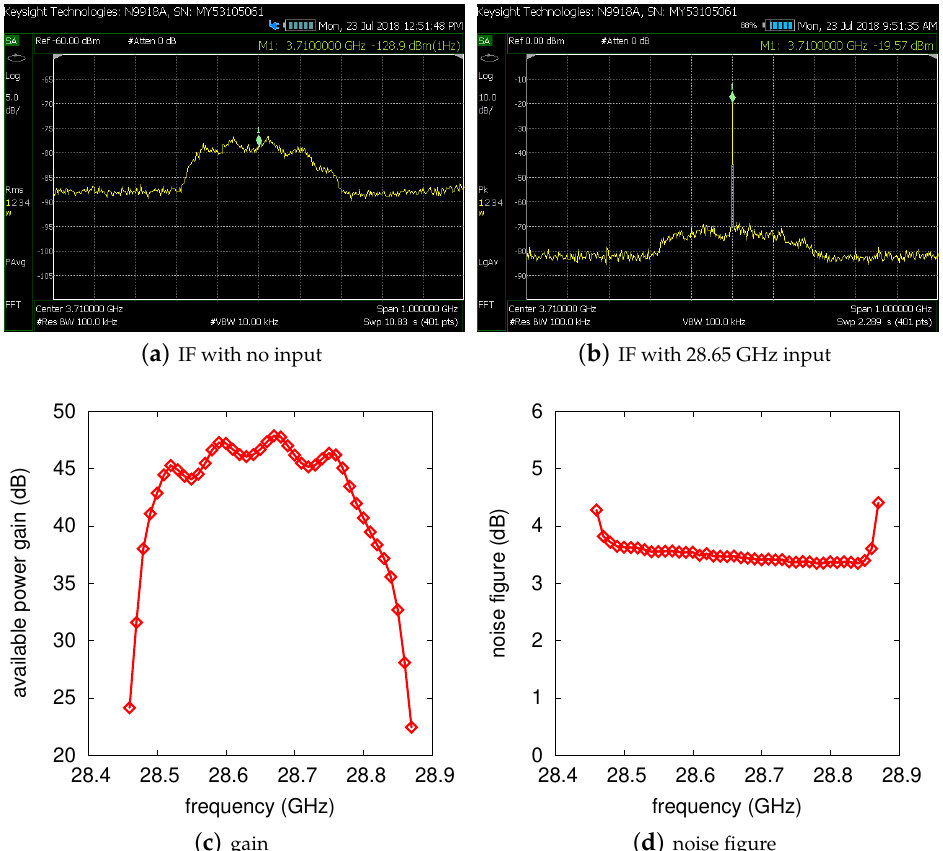
Figure 8. Gain and noise. Measured receiver breadboard performance in different conditions. ( a ) IF signal when the receiver input is terminated on a 50 Ω resistor at 295K; ( b ) IF signal with a 28.65GHz input signal having a − 60dBm available power; ( c ) gain versus frequency; ( d ) noise figure versus frequency. The receiver front-end overall gain is of about 46dB and the corresponding noise figure is 3.4dB. These values include the coaxial-to-CPW end launcher and the feeding line (insertion loss of about 1.5dB). The gain and noise figure measurements have been carried out with the Y-factor method, exploiting the 346C-K01 noise source from Keysight ( ENR = 11.73dB at 28GHz). The receiver breadboard uses a rectangular waveguide image reject filter with 300MHz